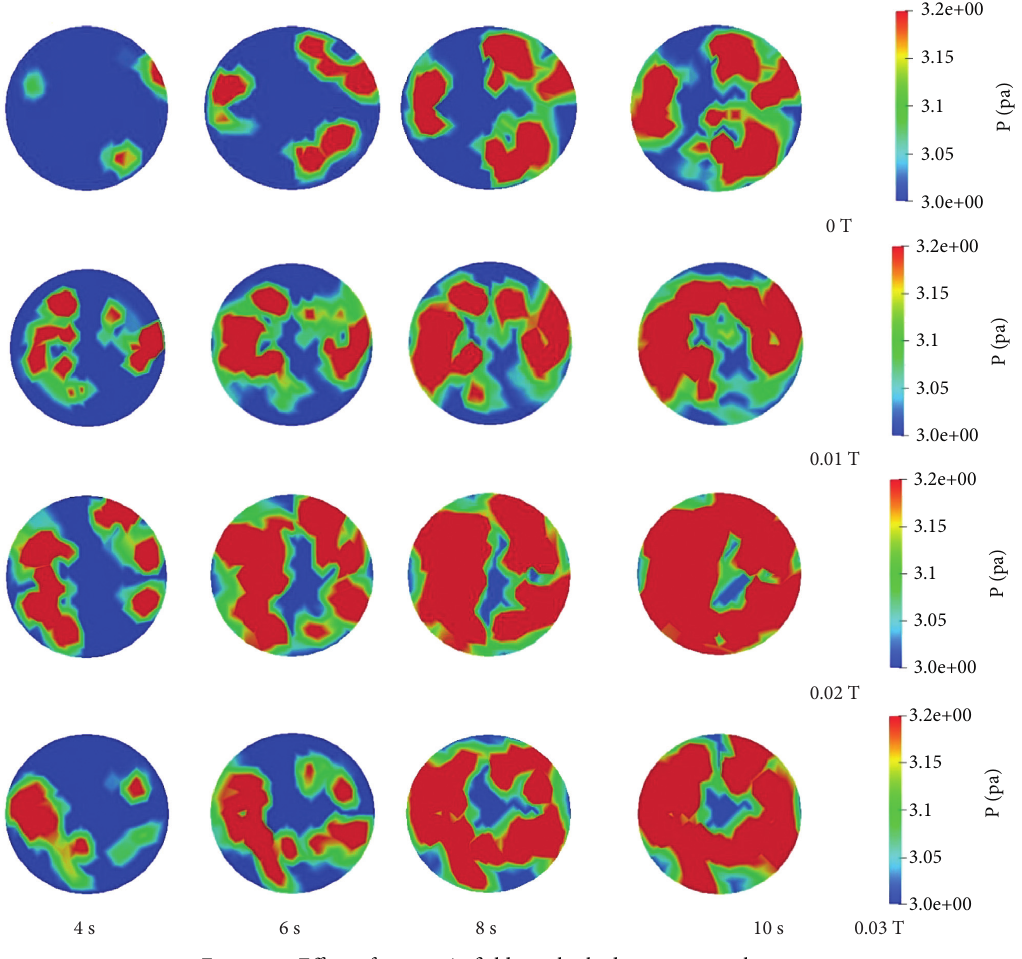
Figure 7: Effect of magnetic field on the bed pressure nephogram.